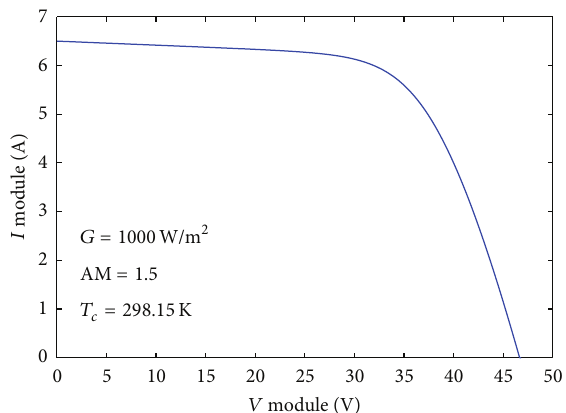
, and 𝑉 𝑡 : block diagram. sh